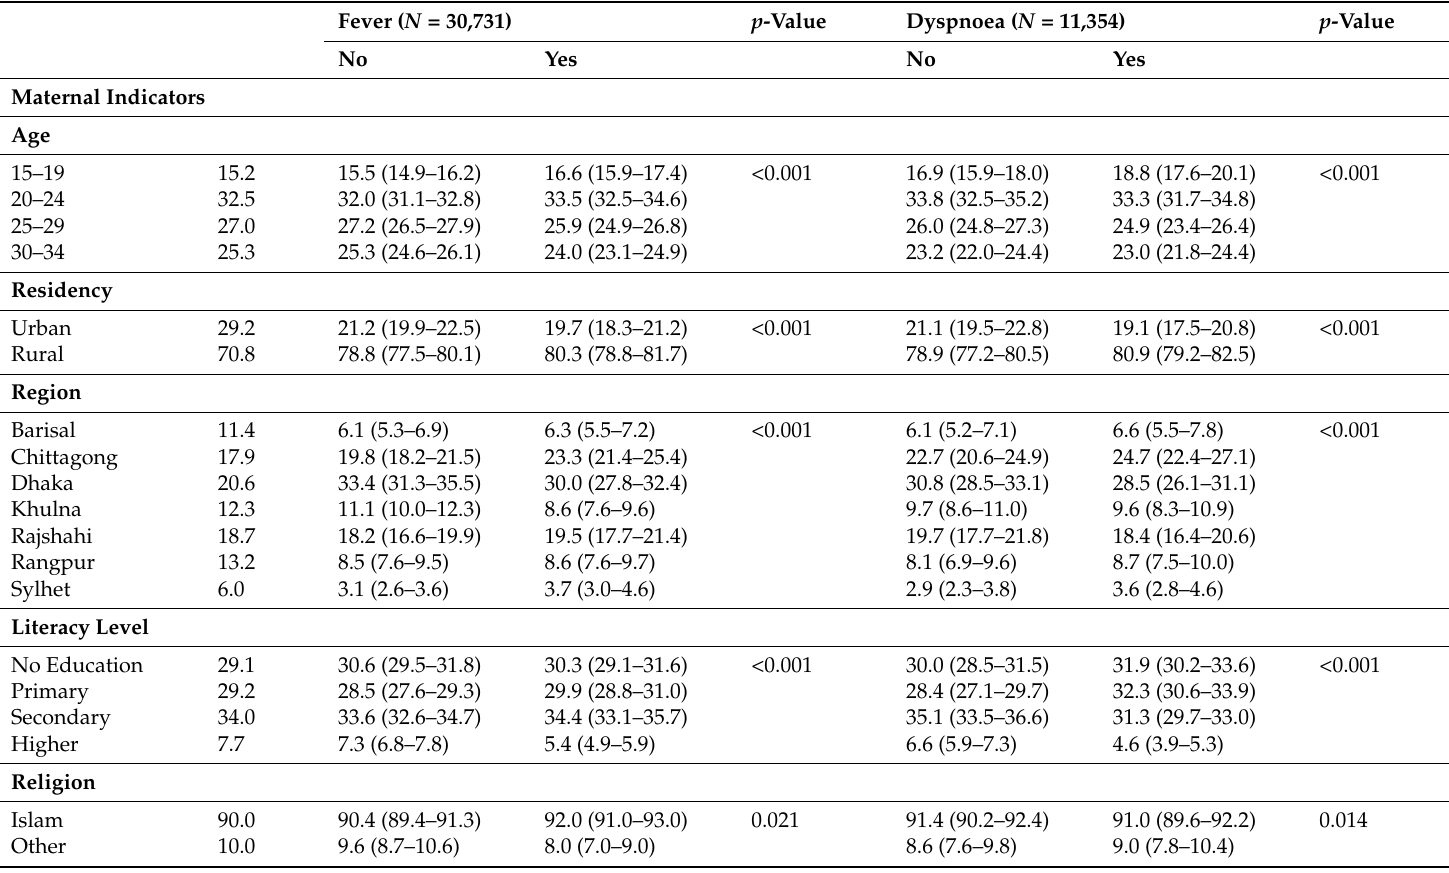
Table A1. Sample characteristics BDHS